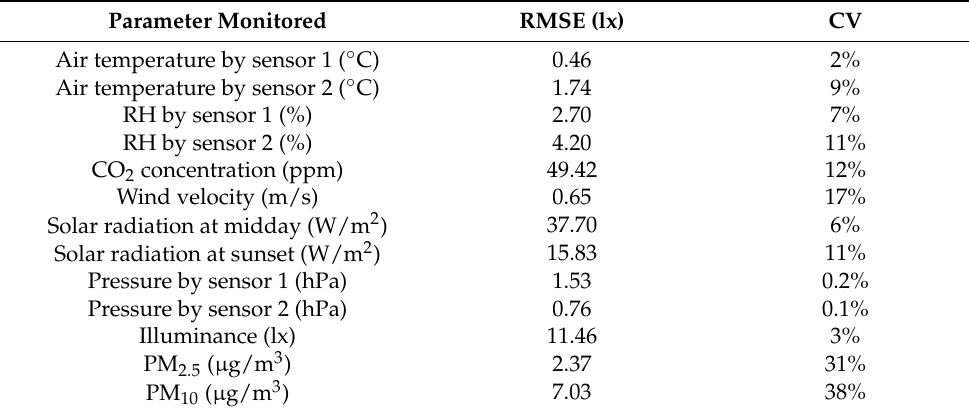
Figure 5. Comparison between the GPS records from the developed wearable and the reference system. Table 2. Root-mean-square error (RMSE) and coefficient of variation (CV) of the developed wearable system parameters compared to those of the reference